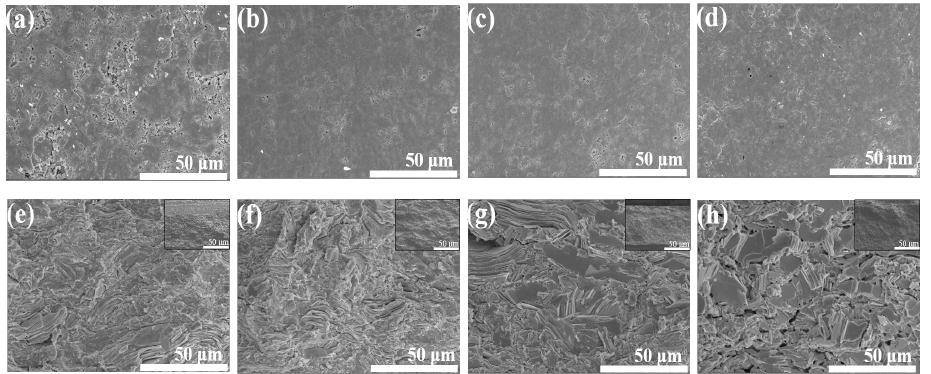
Figure 3. ( a – d ) Top view images; ( e – h ) fractured surfaces and full FE-SEM images of samples at RT, 300, 400, and 500 ◦